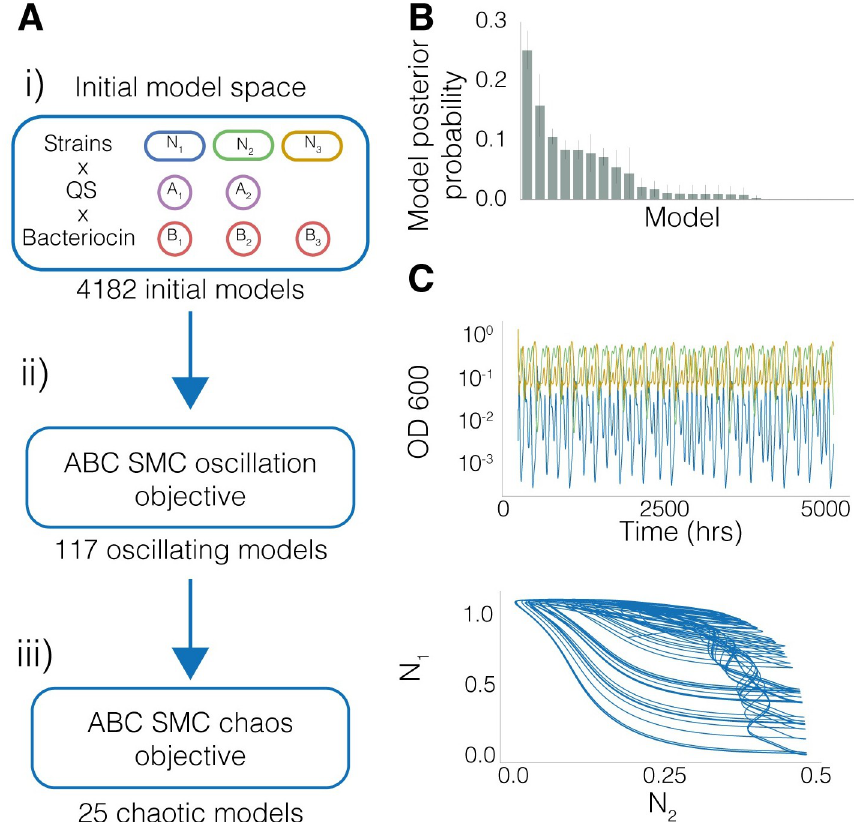
Fig 2. Overview of the pipeline for identifying chaotic topologies. A(i) The initial model space is built from different combinations of engineering options. N 1 , N 2 , N 3 are the three strains being engineered, and can optionally express QS molecules A 1 , A 2 and bacteriocins B 1 , B 2 , B 3 . 4182 models are generated forming our initial model space. A (ii) We then perform ABC SMC for an oscillatory objective, which yielded 117 models that were capable of producing oscillations. A(iii) These form the prior model space for the chaos objective, using a threshold of λ 1 > 0.003, we identify models capable of producing chaotic behaviour B The barchart shows the probability of models for the chaotic objective. The error bars represent the standard deviation. C An example time series representative of the chaos objective posterior distribution. Population densities as optical density (OD) show sustained, nonrepetitive oscillatory behaviour for the three species